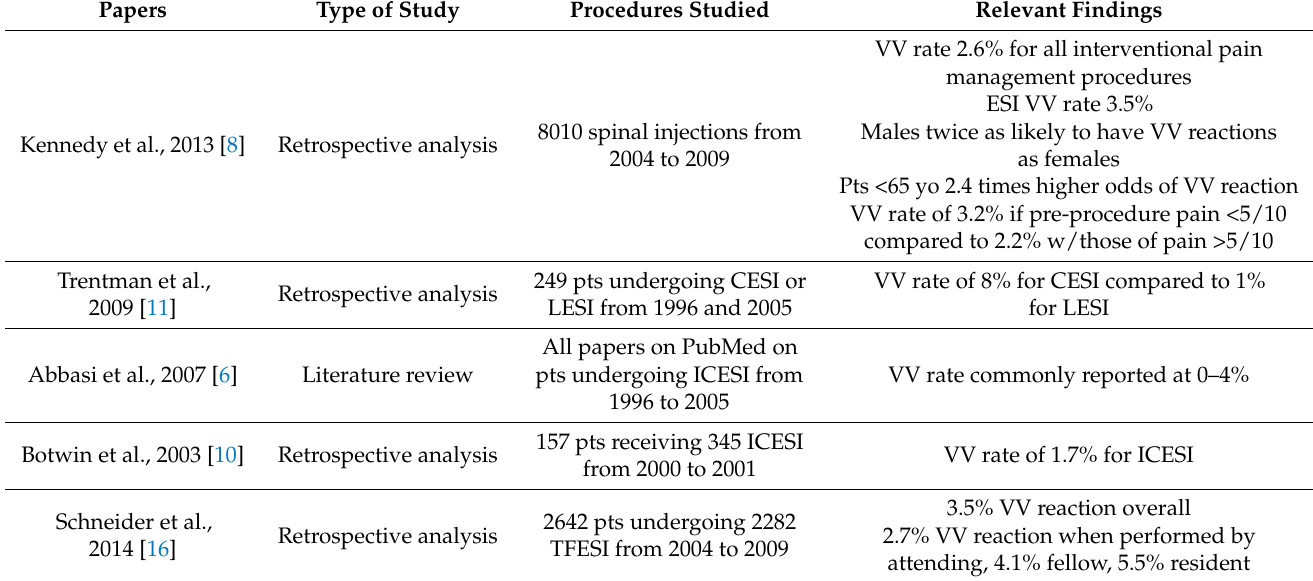
Table 2. Incidence and risk factors of vasovagal reactions during interventional pain management